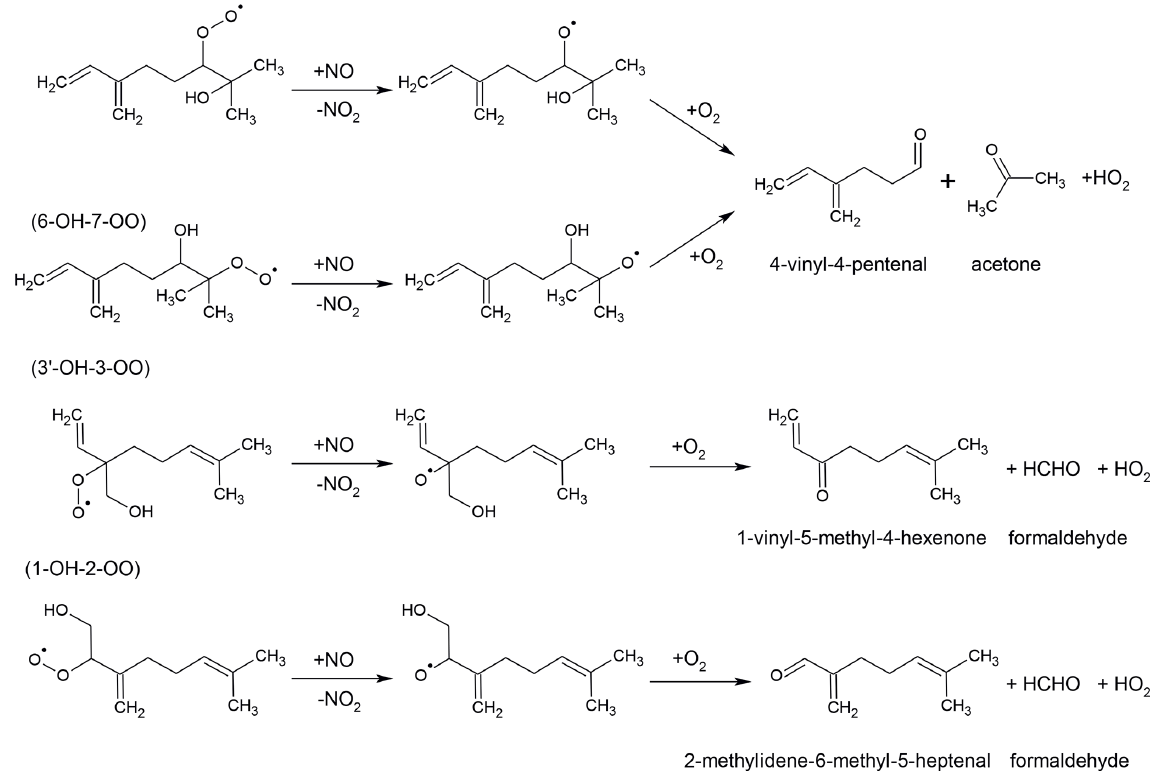
Figure 3. Reactions of the four most abundant myrcene hydroxy peroxy radicals with NO forming HO 2 and carbonyl